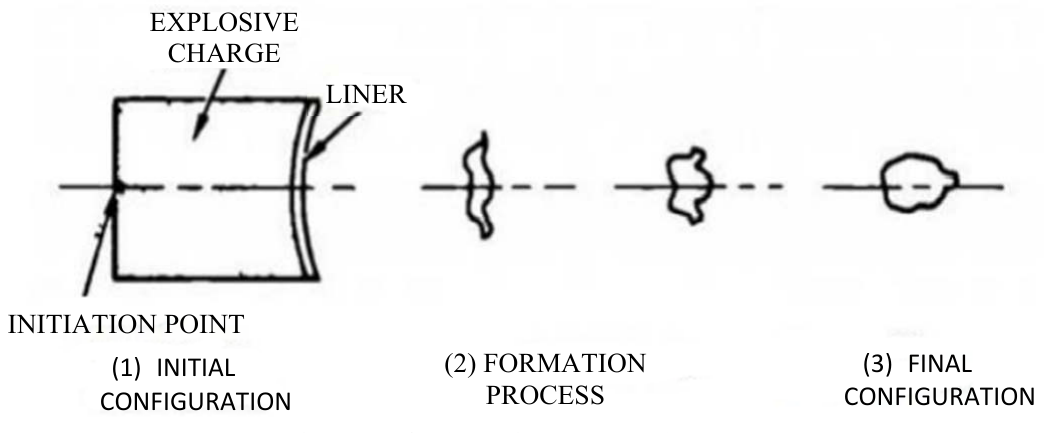
Figure 2. The formation process of EFP [3]